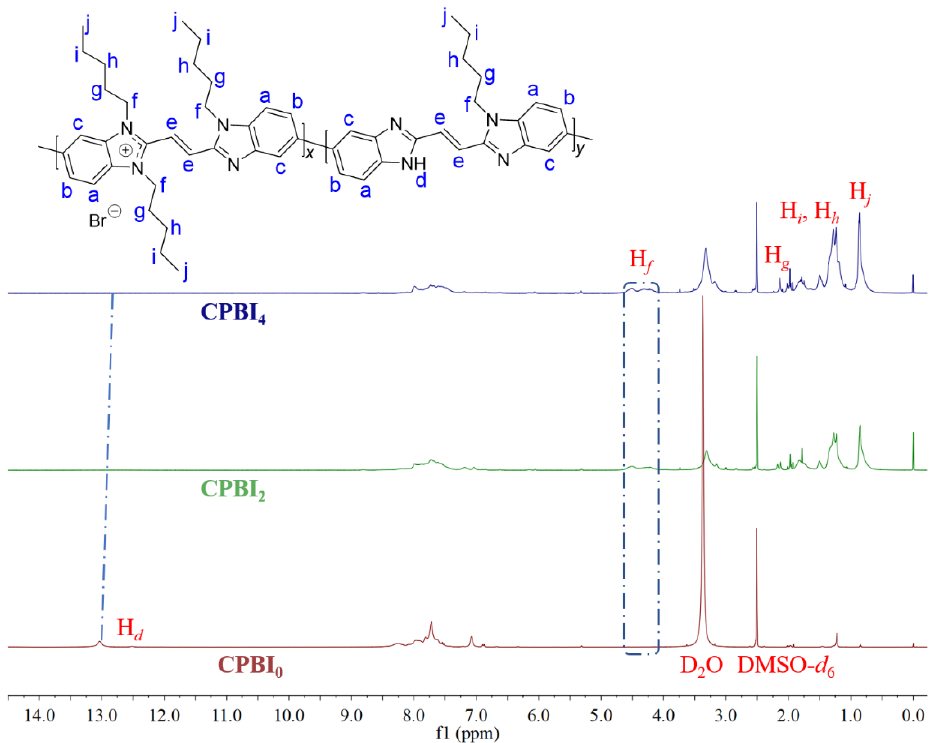
Figure 1. The changes of 1 H NMR spectra of CPBI 0 and CPBI n .